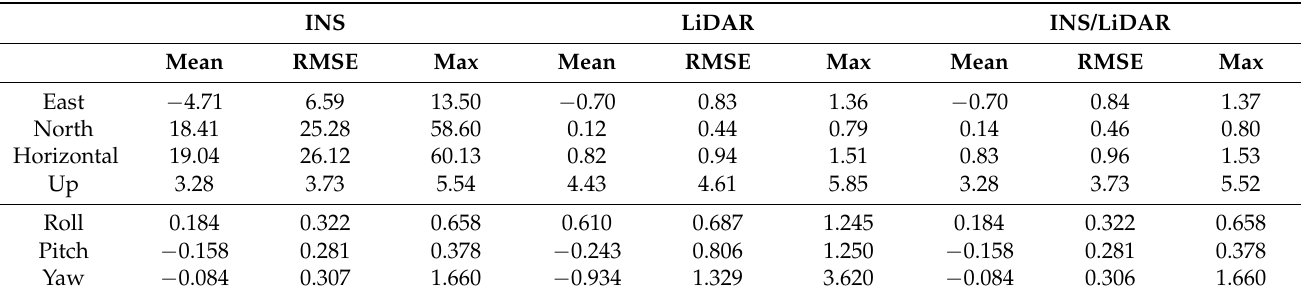
Table A22. D-29—position (m) and attitude (deg) error statistics.